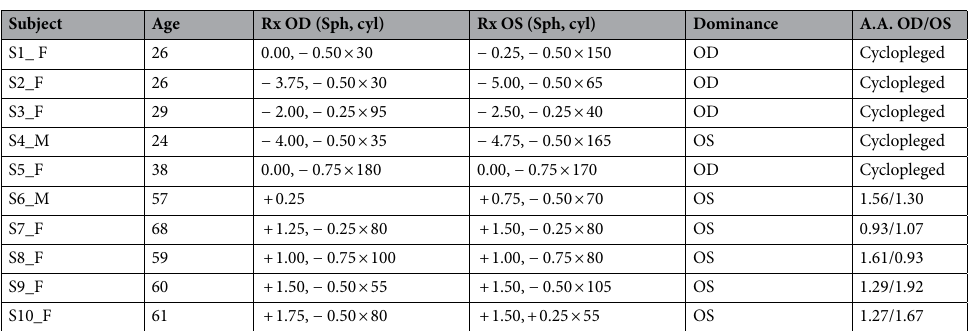
Table 1. Individual data of gender (_M male; _F Female); age (years); Sphero-cylindrical refraction (Rx, sph and cyl in D, x astigmatic angle in degrees) in right (OD) and left (OS) eyes; eye dominance (OD right eye; OS left eye) and amplitude of accommodation (A.A, in D for OD/OS, only in